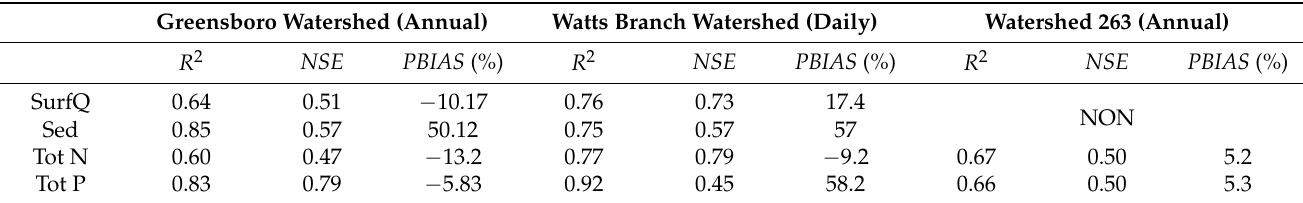
Figure 4. Performance trends of the SWAT calibration and validation in three watersheds: ( a-d ) Greensboro, ( e-h ) Watts Branch, and ( i , j ) Watershed 263. Table 3. Performance statistics of SWAT model for the study watersheds in simulating total flow (SurfQ), total sediment (Sed), total nitrogen (Tot N), and total phosphorus (Tot P), 1993 to 2002 in Greensboro, and 2002 to 2011 in Watts Branch and Watershed 263.